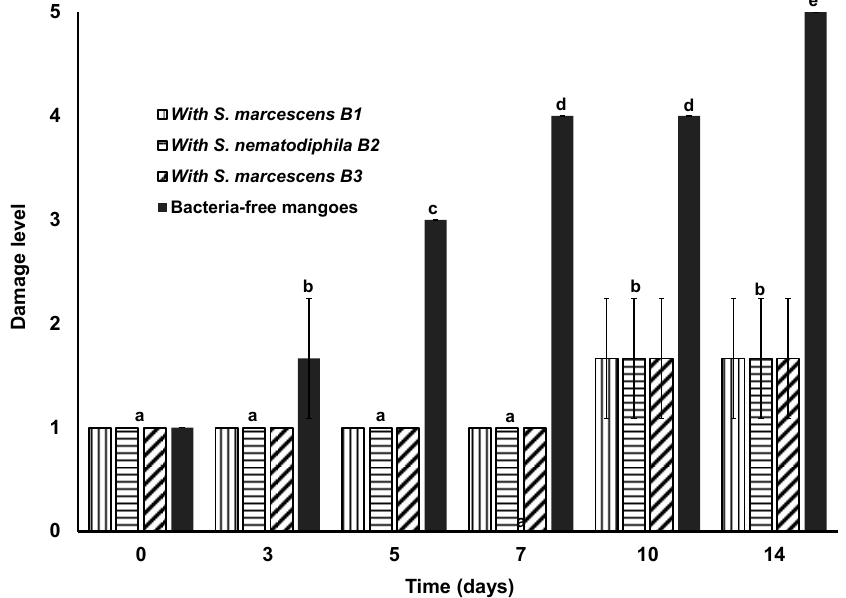
Figure 5. Mangoes inoculated with A. alternata and treated with strains of Serratia. The damage level means, 1: between 0 to 1% of damage; 2: between 1 to 5% of damage; 3: between 6 to 9% of damage; 4: between 10 to 49% of damage and 5: between 50 to 100% of damage. Different letters in the columns on the different days of treatment mean a statistically significant difference ( p < 0.05).